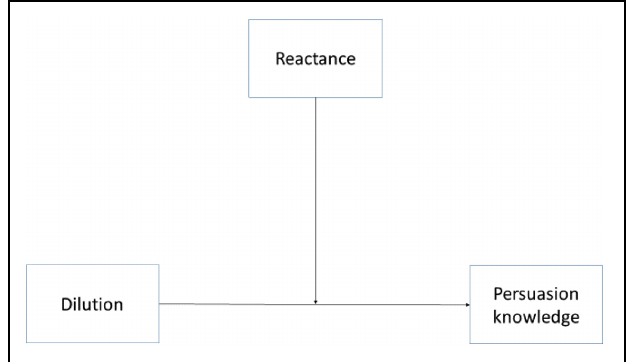
FIGURE 4 | Moderation model.